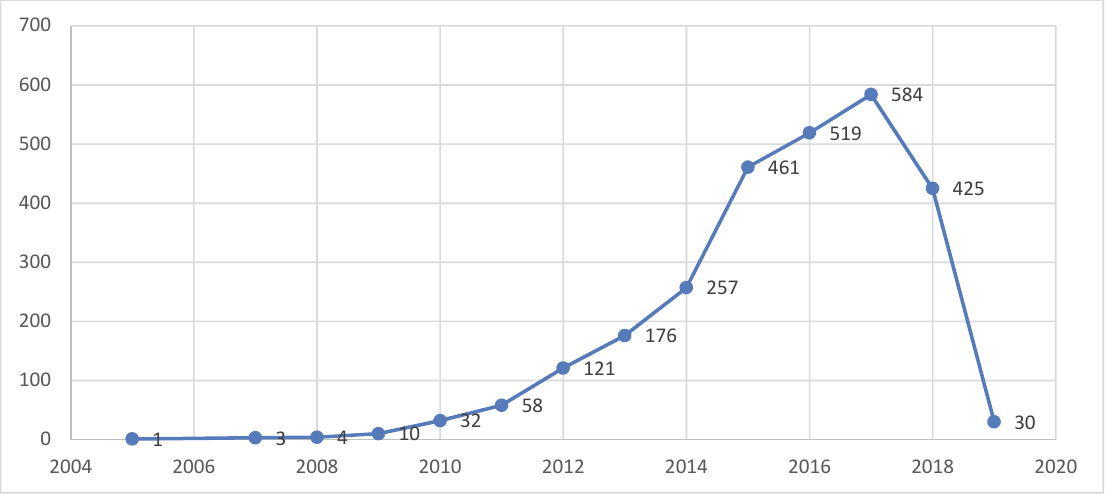
Fig. 1. The Web of Science publications on the analysis of social media and business from 2005 to 2019